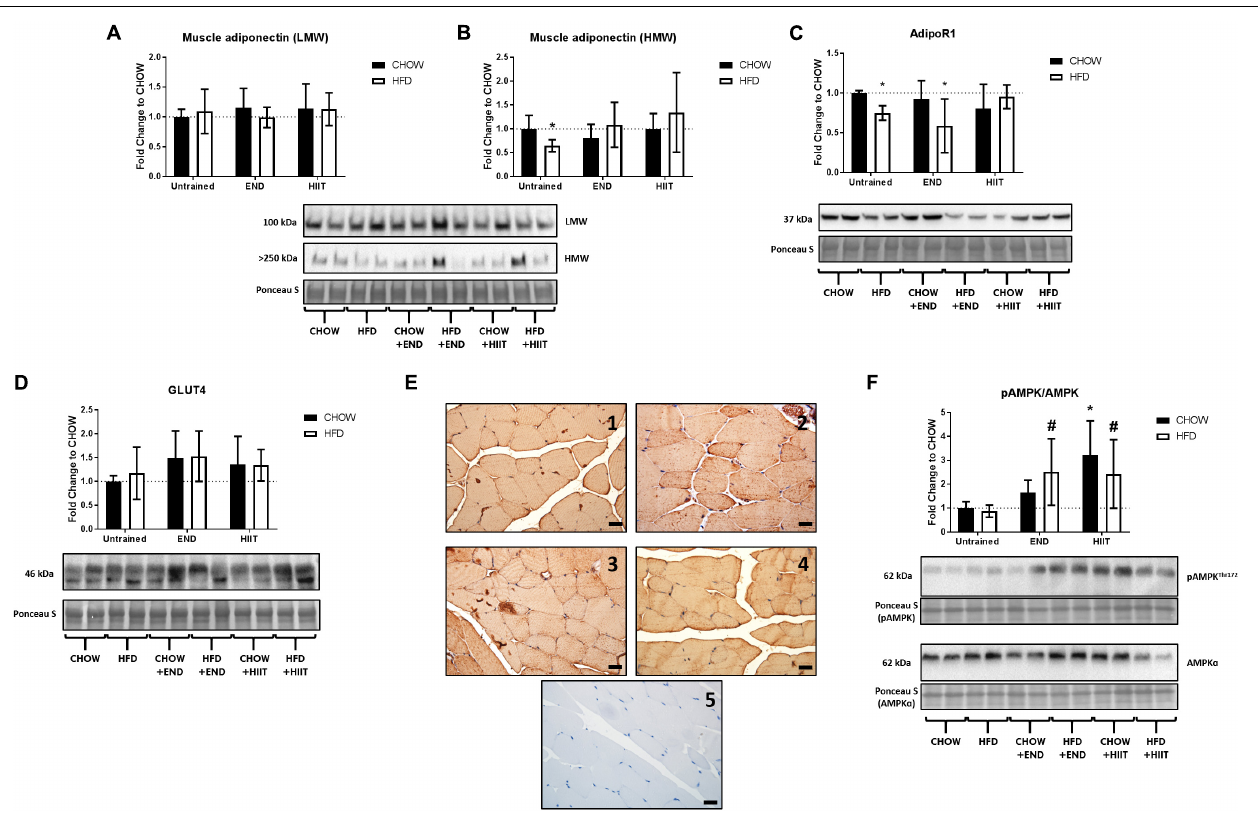
FIGURE 5 | Adiponectin isoforms in muscle, adiponectin receptor 1, GLUT4, and Phospho-AMPK Thr172 /AMPK ratio. Muscle low-molecular weight (LMW) adiponectin (A) and high-molecular weight (HMW) adiponectin (B) ; muscle adiponectin receptor 1 (AdipoR1; C ), muscle GLUT4 (D) , muscle Phospho-AMPK Thr172 /AMPK ratios (F) and their representative blots below its respective graph with its membrane stained with Ponceau S used as loading control. Data are presented as means ± SD and the number of animals in each group is 8. ∗ p < 0.05 vs. CHOW untrained; # p < 0.05 vs. HFD untrained by Two-way ANOVA with Tukey’s and Sidak’s post hoc tests. Representative cross-sections of quadriceps muscle with GLUT4 immunohistochemistry determined by immunoperoxidase stain (E) , and nuclear counter-staining with haematoxylin. CHOW untrained (1), high-fat diet untrained (2), HFD+END (3), and HFD+HIIT (4) are displayed. A negative control without primary antibody is shown in (5). The size bars indicate 20 µ m and images are at 40 × magnification. As no clear differences were seen in CHOW mice before vs. after exercise training, those images are not shown.